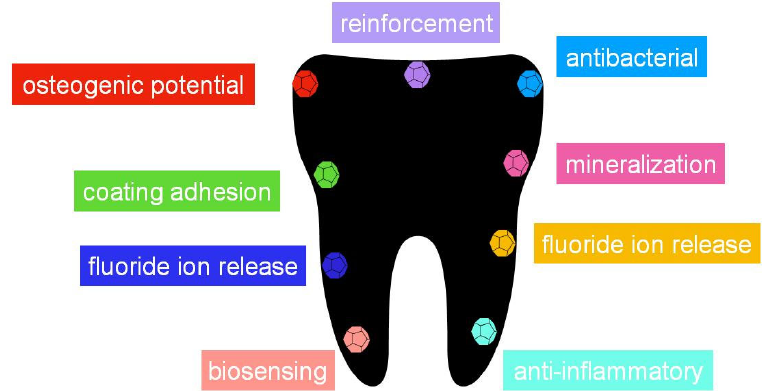
Figure 4. Some of the most important properties that can be enhanced in dentistry with the use of a